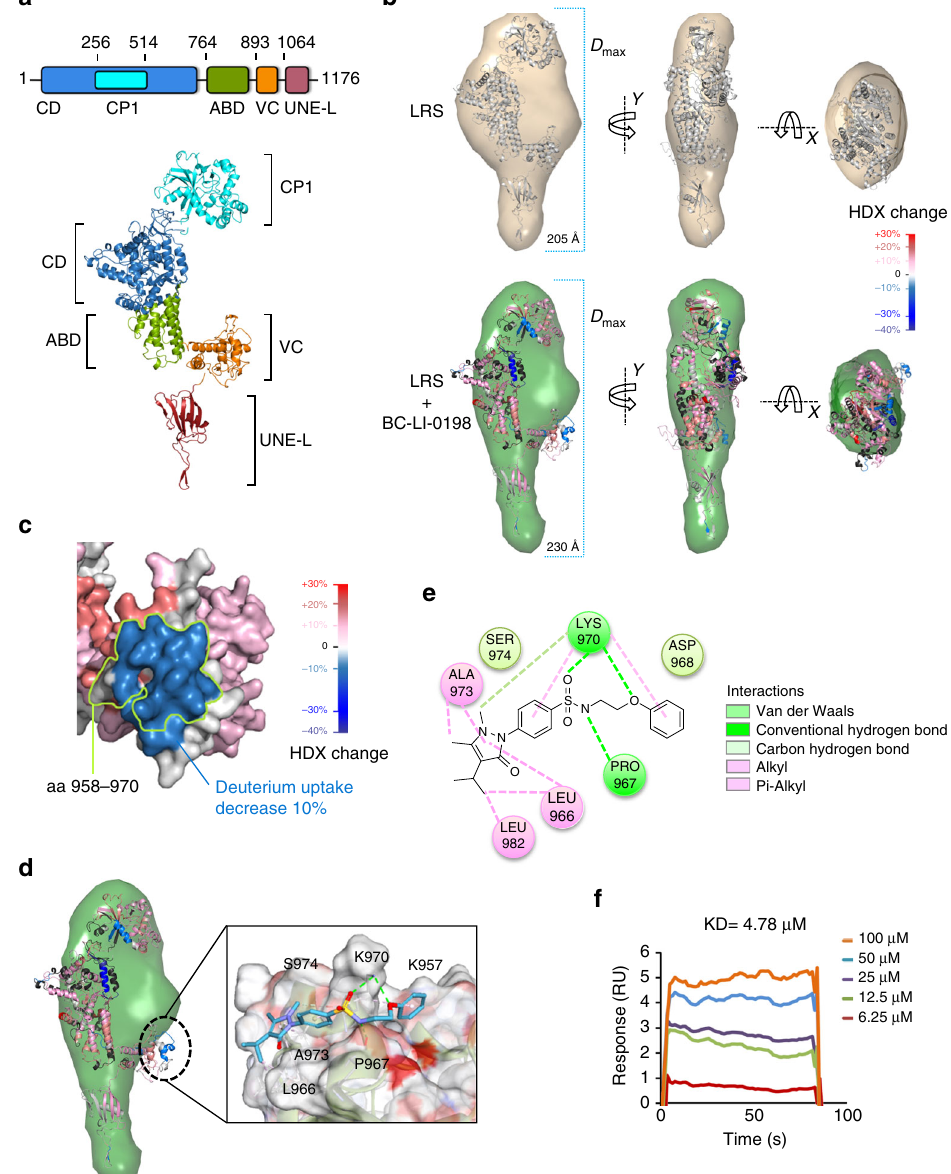
Fig. 2 Determination of BC-LI-0186 docking site. a Structural modeling of human cytoplasmic LRS. Upper : Schematic representation for the domain arrangement of LRS. Lower : The structural model of human LRS, which fi t to the LRS SAXS envelope. b SAXS and HDX-MS analysis of the BC-LI-0198 effect on LRS conformation. Structural models of the naked LRS ( upper ) and BC-LI-0198-bound LRS ( lower ). D max values of SAXS envelopes were indicated by dashed lines . Colors indicate changes of deuterium uptake compared with naked LRS as shown in the color gradient bar . c Surface representation of deuterium uptake changes of the LRS residues critical for the interaction with RagD upon BC-LI-0198 binding. Difference in deuterium uptake changes was shown in surface colors ( color gradient bar ). The residues critical for the interaction were circled by lemon line . d Structural modeling of BC-LI-0186 docking position in the pocket of LRS based on HDX-MS analysis. e The chemical binding residues are shown as circles . f The binding of BC-LI-0186 to LRS S974A mutant was determined by SPR as described in Methods. The inset represents the KD value between LRS S974A and